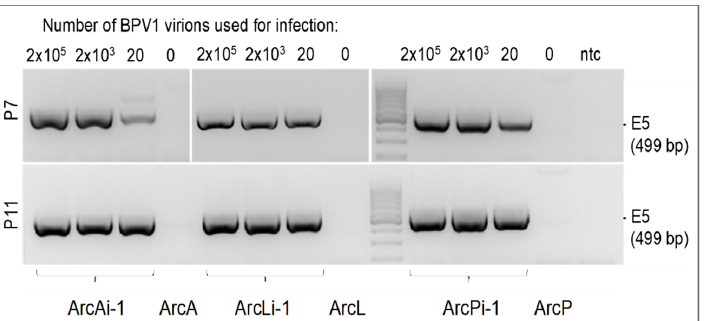
Figure 2. Infection of fibroblasts achieved with 20 to 2 × 10 5 BPV1 virions. Standard consensus BPV1/2 E5 PCR from DNA of BPV1-infected versus non-infected equine fibroblasts from P7 and P11. L: 100 bp DNA Ladder (Thermo Fisher Scientific); ntc: no-template control (sterile water).